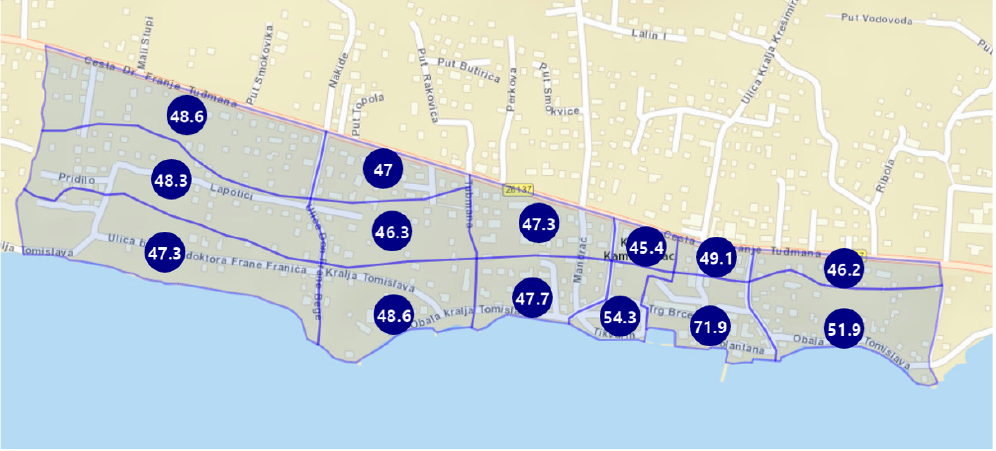
Figure 21. Results of the risk analysis for seismic, flood and extreme waves hazards for Level 2 (Scenario S-F-EW L2).